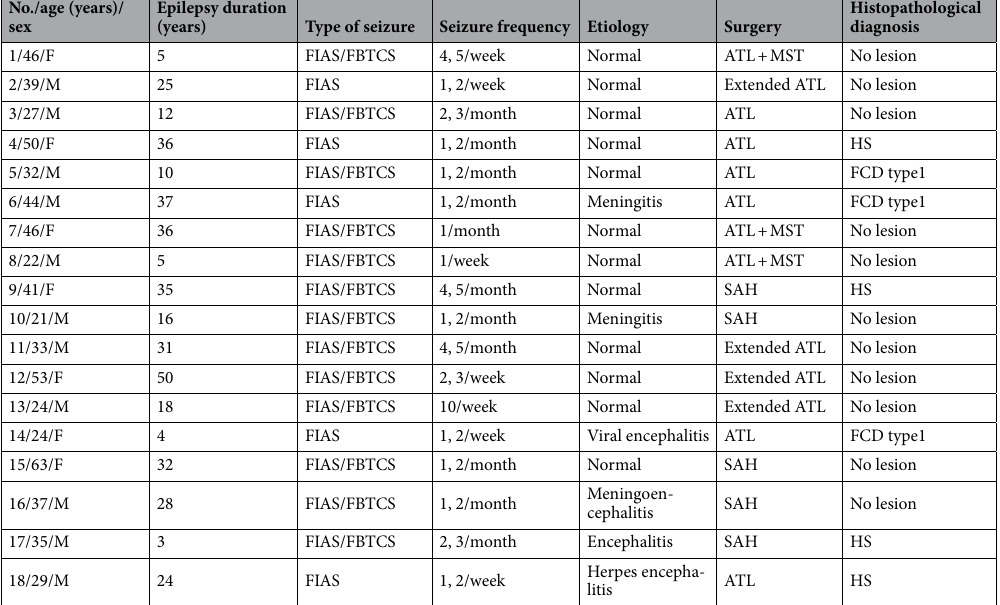
Table 1. Patients characteristics. F, female; M, male; Rt., right; Lt., left; Bil, bilateral; FIAS, focal Impaired awareness seizure; FBTCS, focal to bilateral tonic-chronic seizure; ATL, anterior temporal lobbectomy with